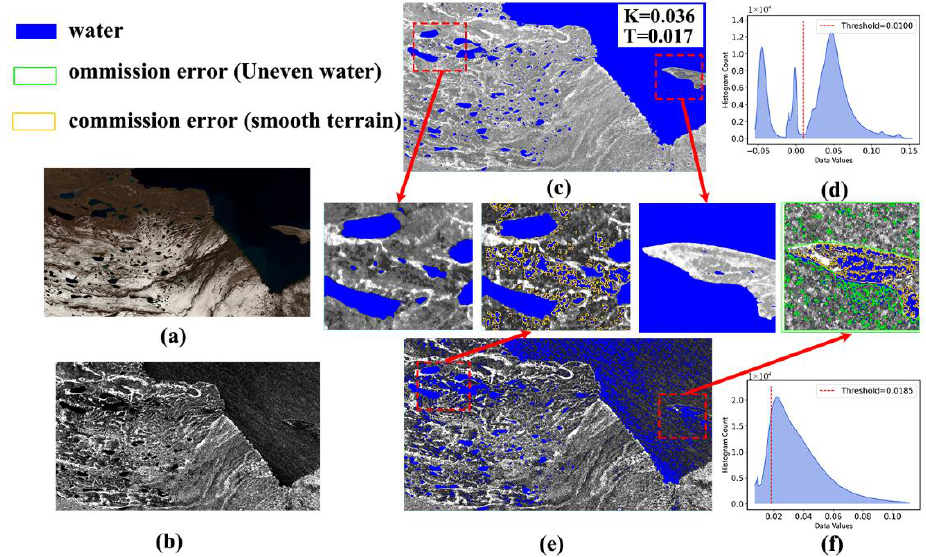
Figure 11. Waterbody extraction map for the for the Ulan-Ula Lake area under strong wind: ( a ) Optical image. ( b ) SAR image. ( c ) Water extraction based on the SOWI. ( d ) SOWI histogram. ( e ) Water extraction based on VV. ( f ) VV histogram. The red lines in ( d , f ) represent the threshold.